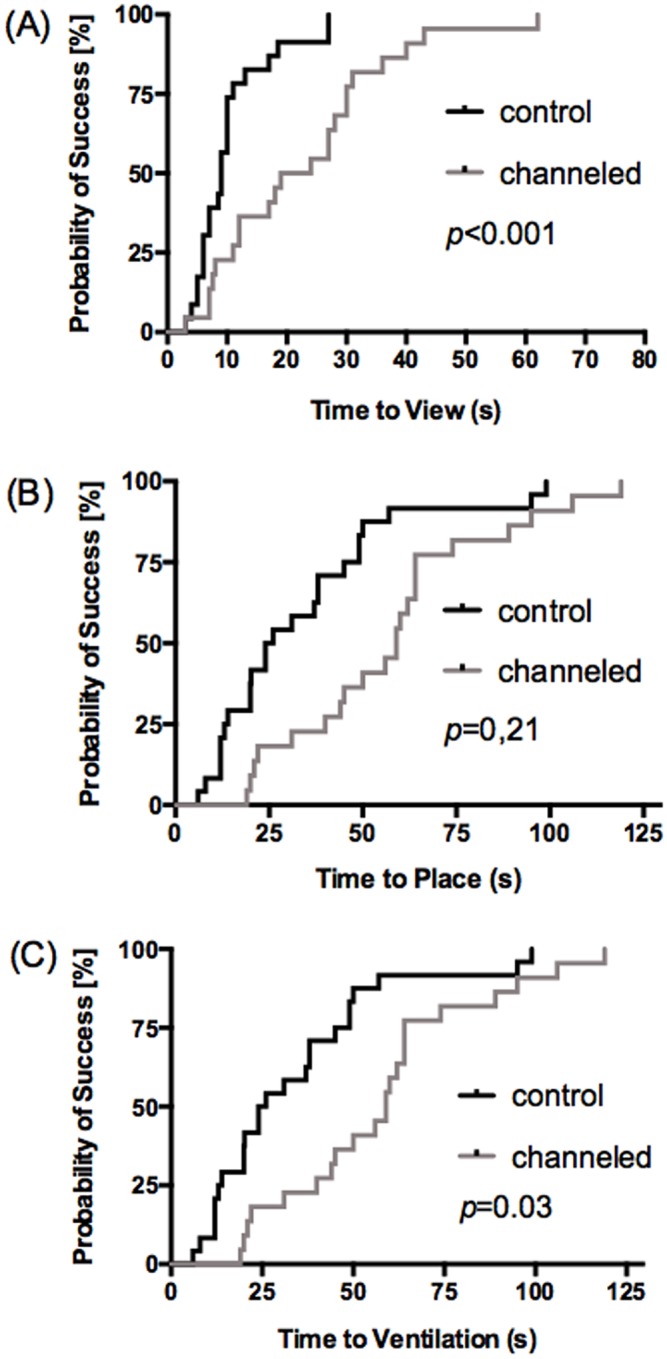
Time sequnce of intubation.Time steps of (A) differences in Time to view (B) differences in Time for place the TT (C) differences in overall intubation time; Data are given in Kaplan-Meier curve and median.